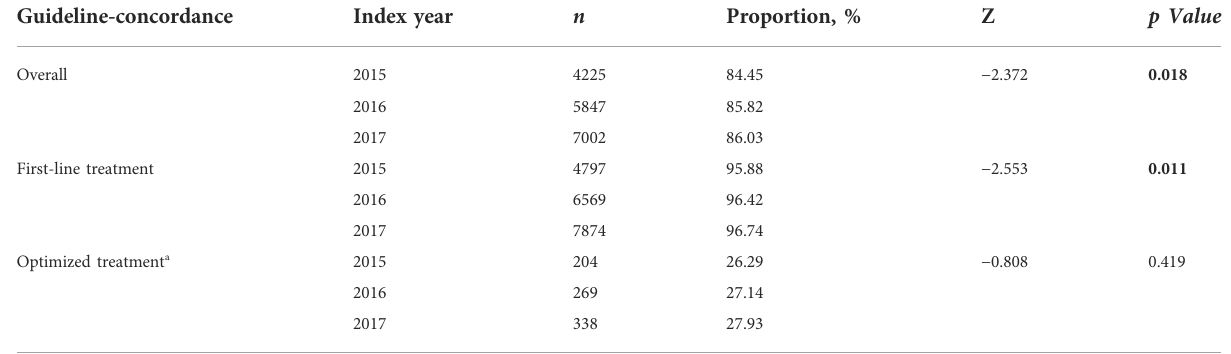
TABLE 2 Trend comparison of concordance proportions between